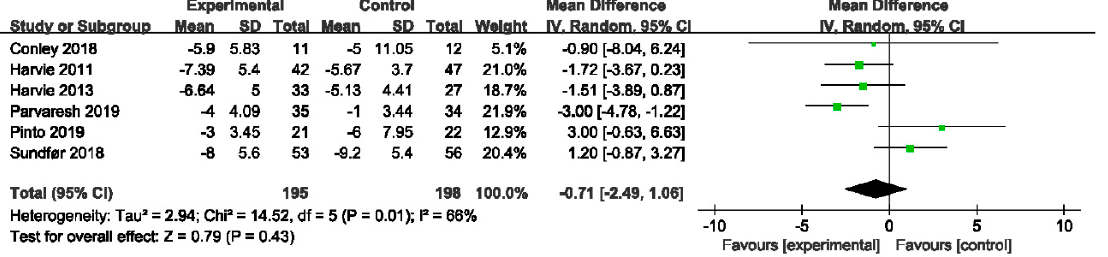
Figure 6. Forest plot for body composition in trials that compared IER with CER. Abbreviations: CI, confidence interval; FM, fat mass; FFM, fat-free mass; IER, intermittent energy restriction; CER, con- tinuous energy restriction. The unit of mean difference in FM and FFM is kg. 3.5. The Methodological Quality of the Included Reviews According to AMSTAR 2